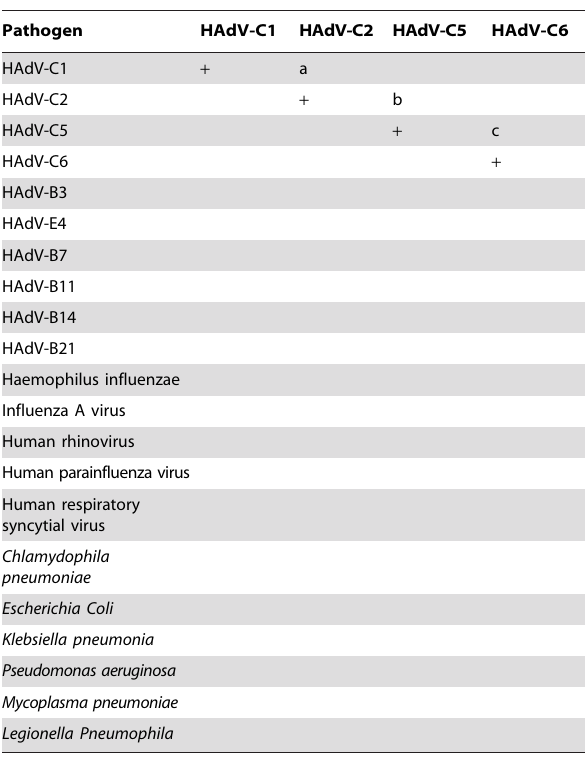
Table 3. Specificity table of each HAdV assay.